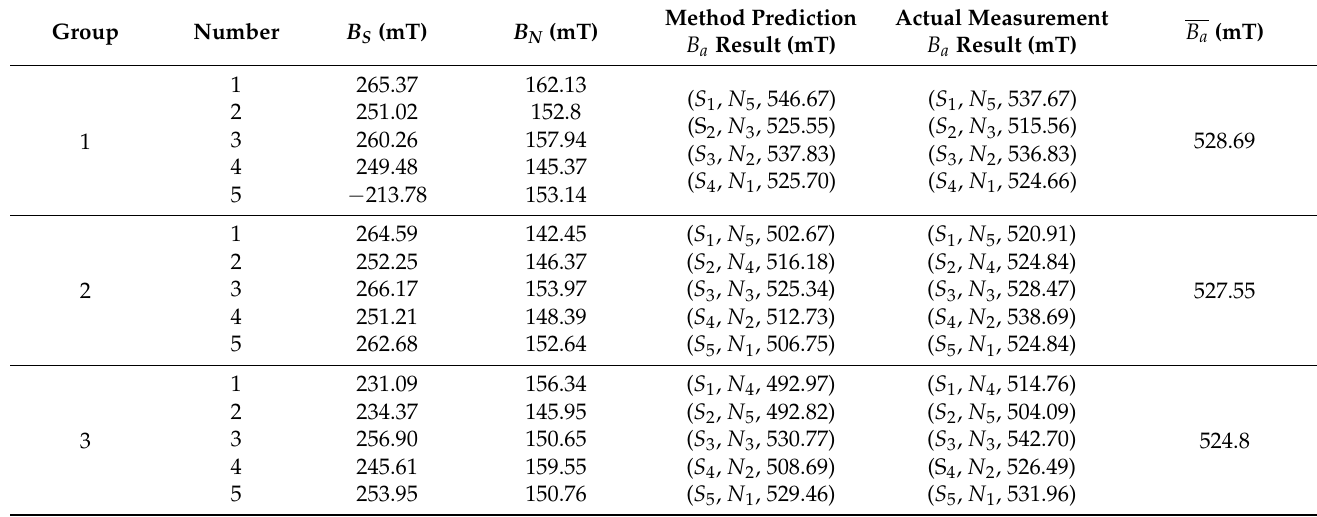
Table 3. TMSP matching